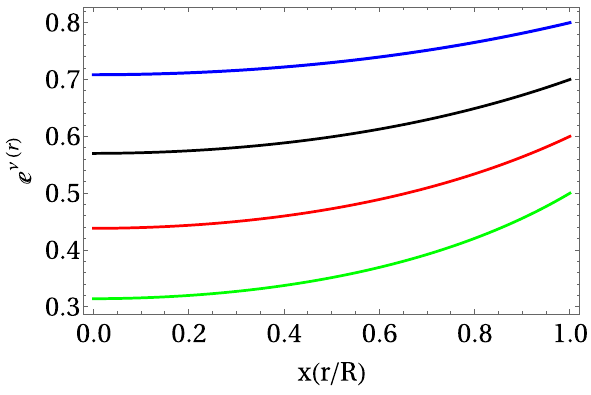
Fig. 1 TemporalmetricforModelIforcompactfactors:0.1(blueline), 0.15 (black line), 0.20 (red line) and 0.25 (green